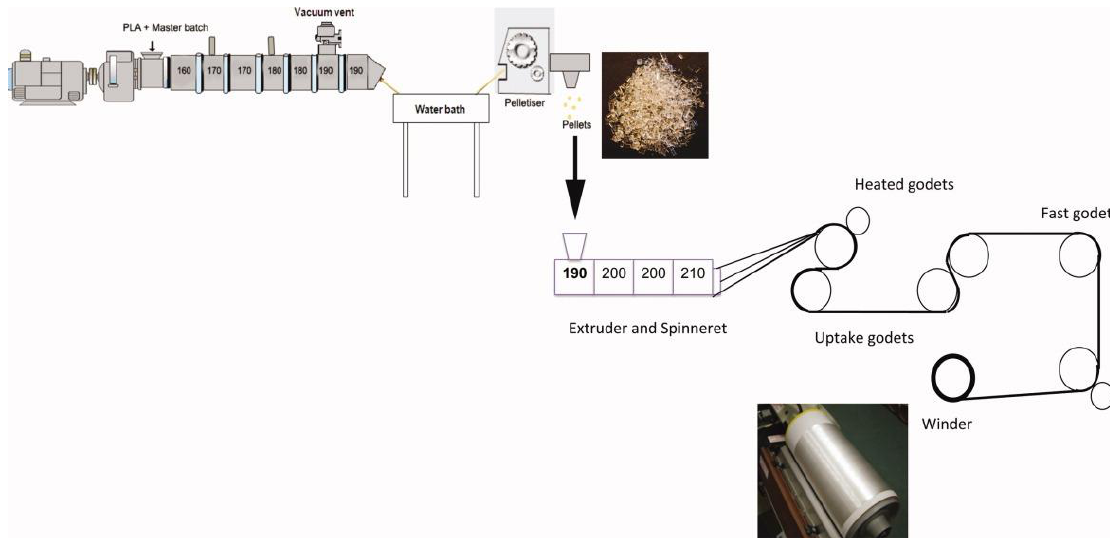
Figure 4. Schematic representation of the melt spinning of PLA and PLA/CNC fibers. Reprinted with permission from [70].